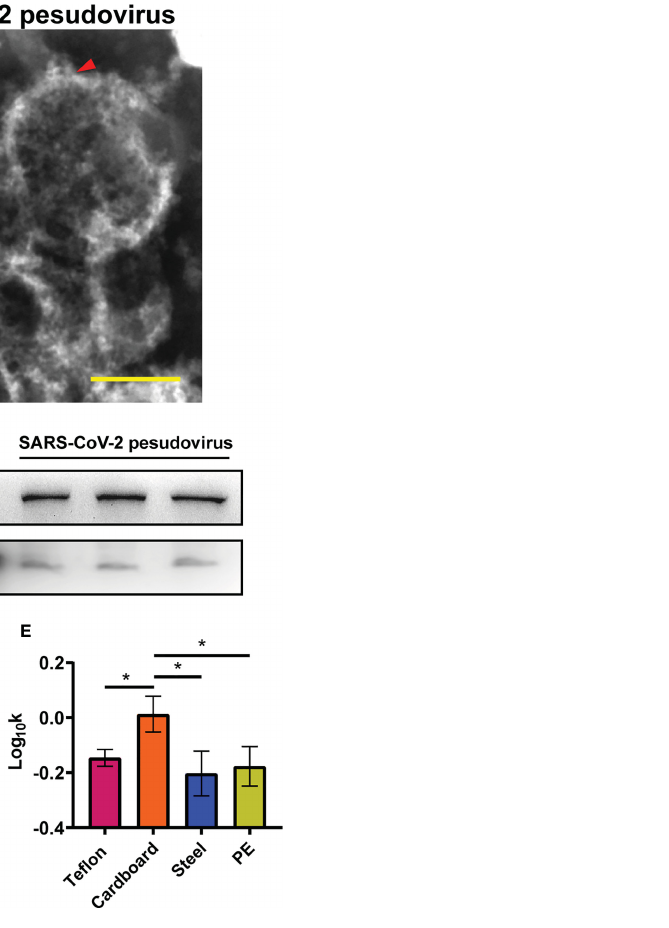
FIGURE 1 Identi fi cation of SARS-CoV-2 pseudovirus. (A) Structure analysis of lentivirus and SARS-CoV-2 pseudovirus using Transmission electron microscopy (TEM) assay. (B) Infectivity of SARS-CoV-2 pseudovirus on 293T-hACE-2 cells. (C) The protein expression of S-spike in lentivirus and SARS-CoV-2 pseudovirus, HIV Gag-p24 is a lentivirus capsid protein and also exists in pseudovirus. (D) Decay curves of SARS-CoV-2 pseudovirus over 3 days on the surface of Te fl on fi lm, cardboard, stainless steel, and PE plastic. The measurements were linearized premised on fi rst-order decay, in which the natural log (ln)-transformed measured concentration at each time point was divided by the concentration at time zero. (E) Log10-transformed mean pseudovirus decay rate constants k of SARS-CoV-2 pseudovirus on the surfaces of different materials at 16°C. Scale bar: 100 nm (A) and 200 m m (B) .